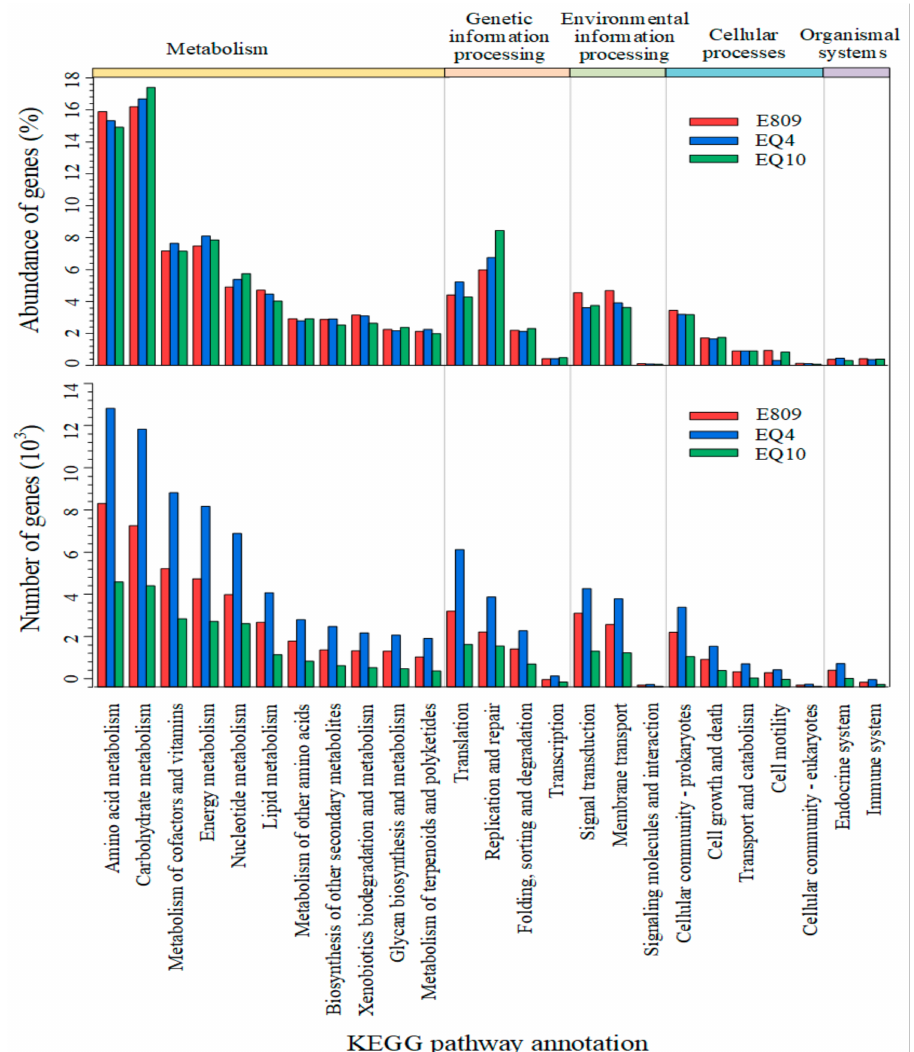
Figure 5. The predicted genes in the metagenome were matched to the functional categories in the KEGG